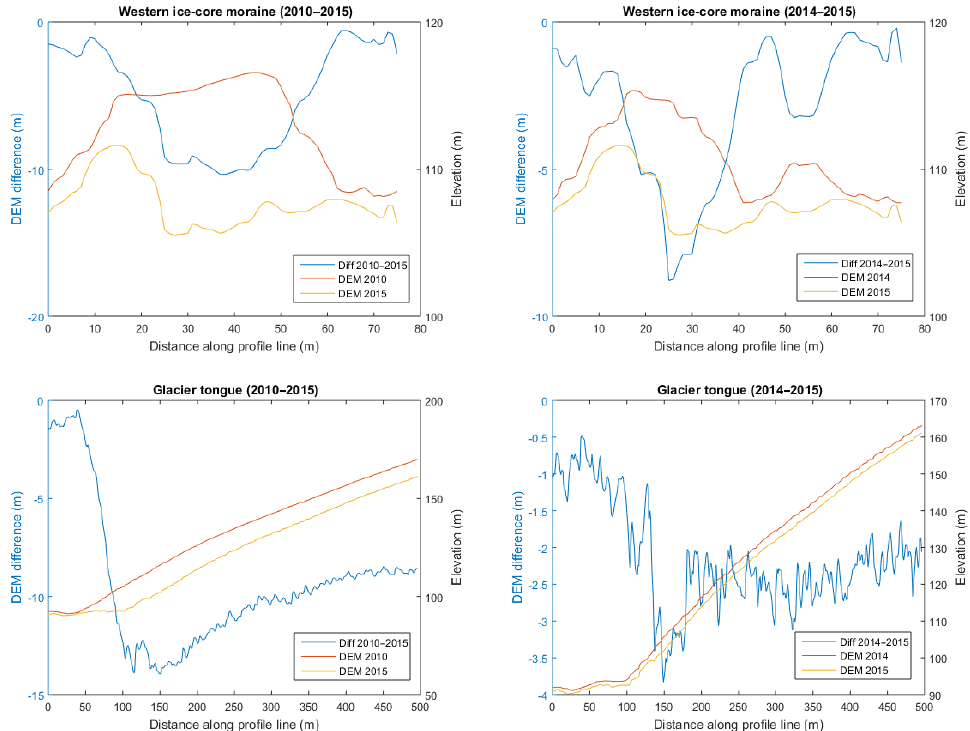
Figure 12. Profiles extracted from the 2010, 2014, and 2015 DEMs, and DEM differences associated with them. Top is profile “a” from Fig. 11 and bottom is profile “b”. Blue lines are DEM differences (scale on the left axis) while red and orange are the DEM values (scale on the right axis; red is the older of the two